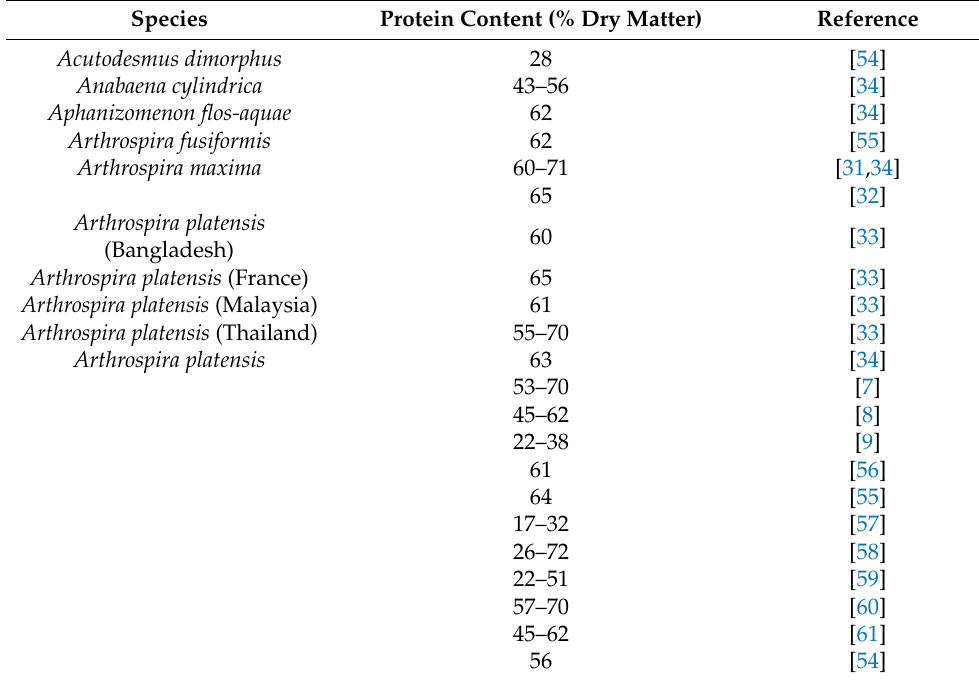
Table 1. Protein content of different microalgal